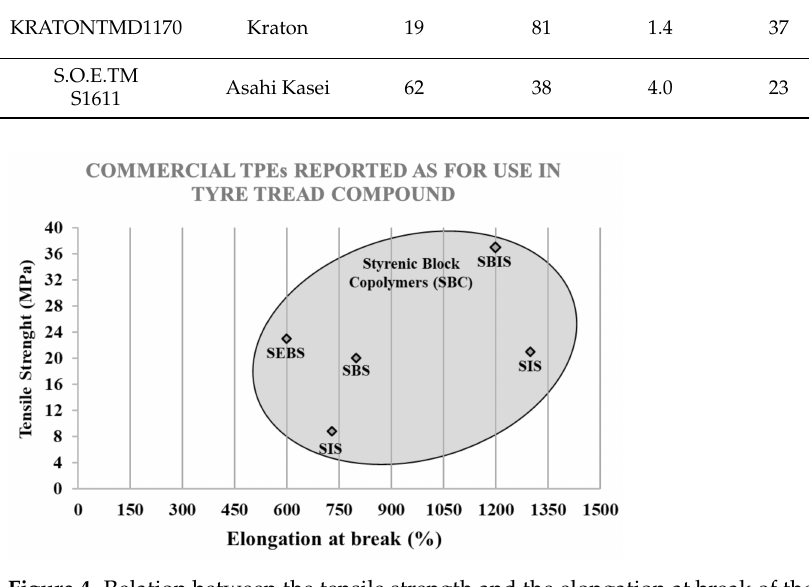
Figure 4. Relation between the tensile strength and the elongation at break of the TPEs reported in Table